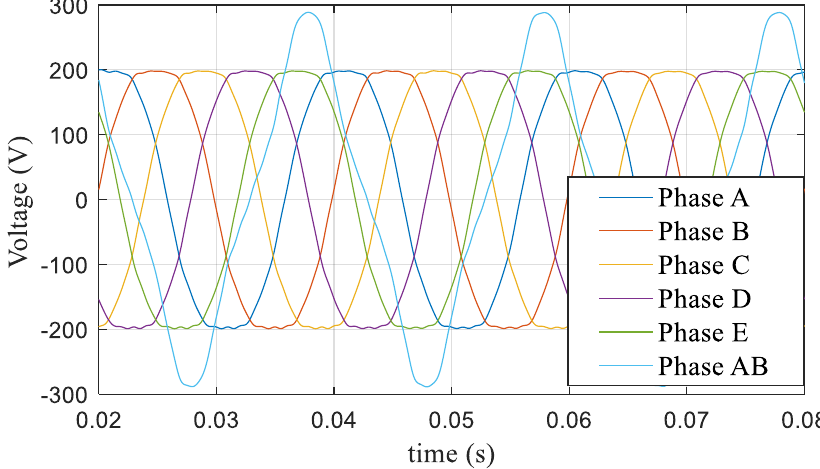
Figure 20. Five-phase voltage and AB (AB = Phase A − Phase B) line voltage at m = 1.1.